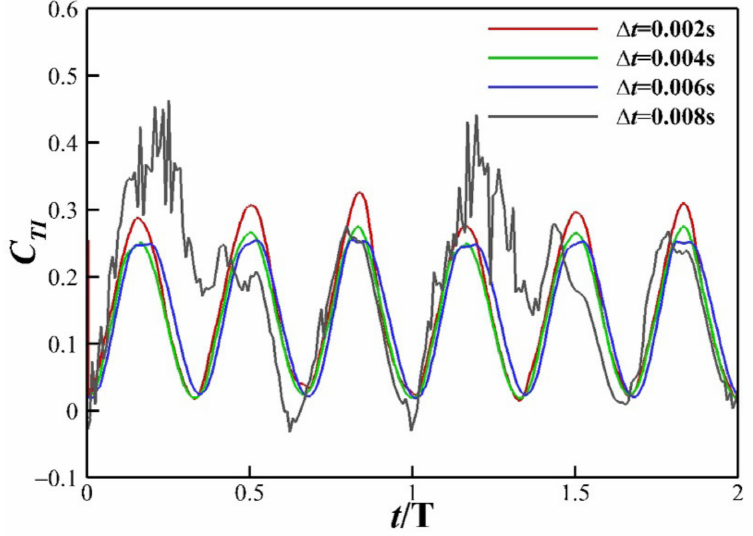
Figure 6. VATT array variation of torque coefficient of the turbine in four different time